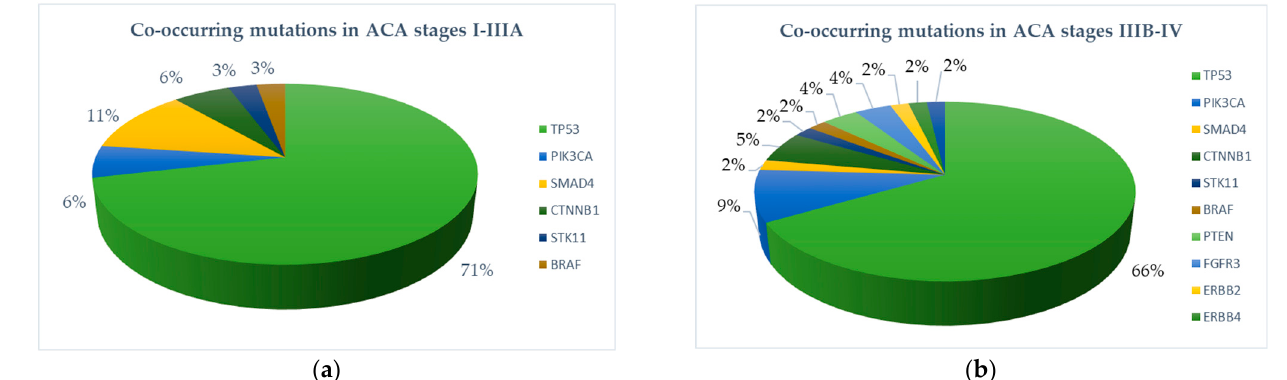
Figure 3. Proportions of co-occurring mutations in EGFR-mutated primary pulmonary adenocarcinoma. ( a ) Early-stage ACA (stages I–IIIA). ( b ) Advanced-stage ACA (stages IIIB–IV).